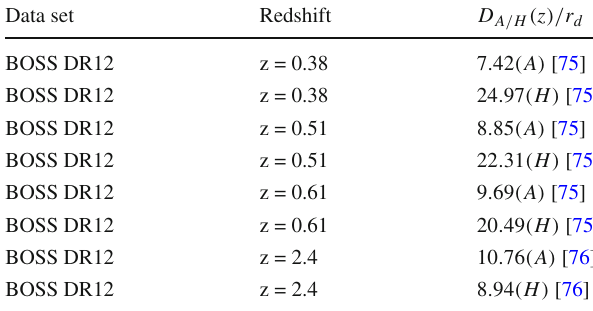
Table 3 Anisotropic BAO data